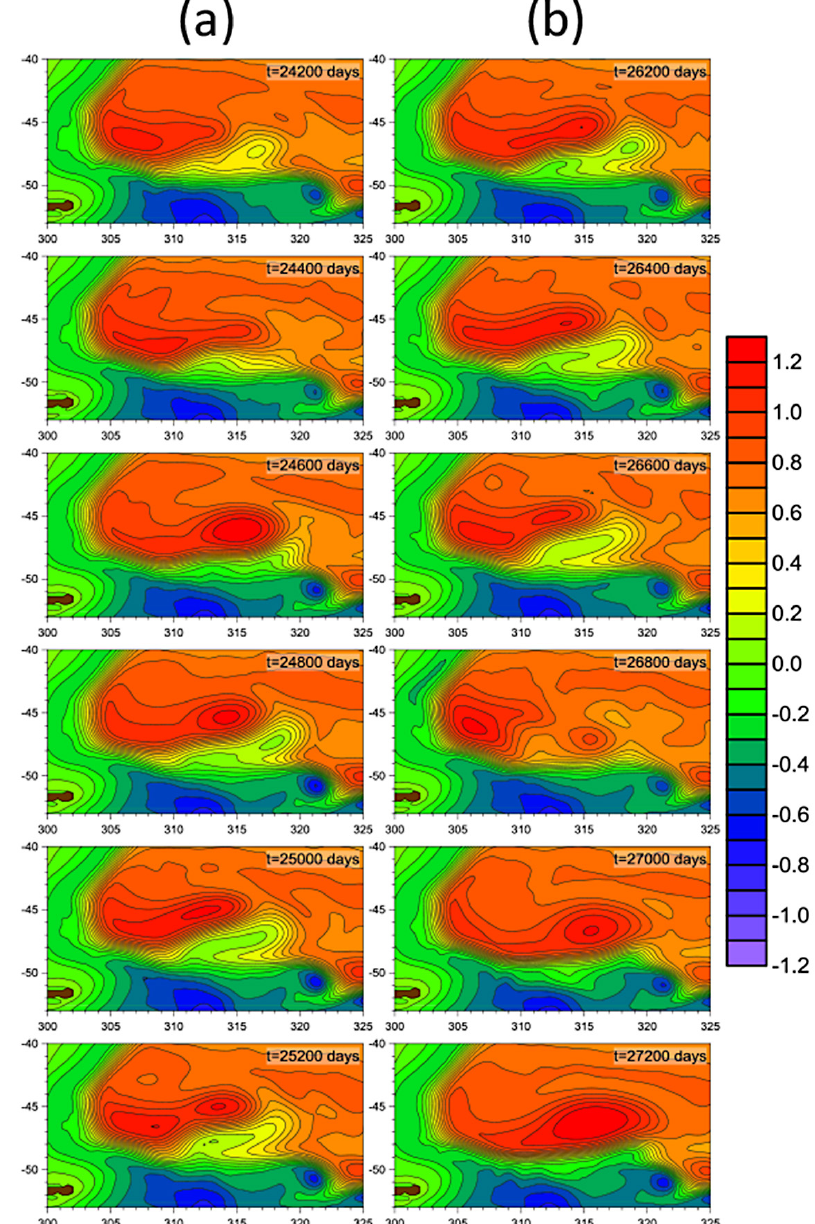
Fig. 9. Snapshots of the low-frequency SSH signal (in m) corresponding to the green (a) and red (b) dots in Fig. 8.